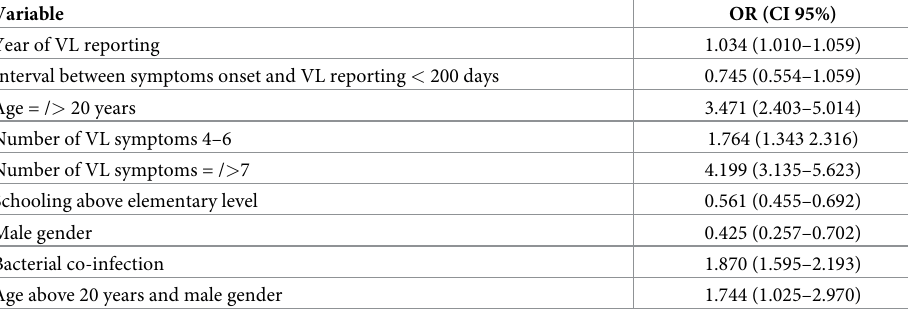
Table 5. Final multiple modeling for factors related to VL case-fatality.